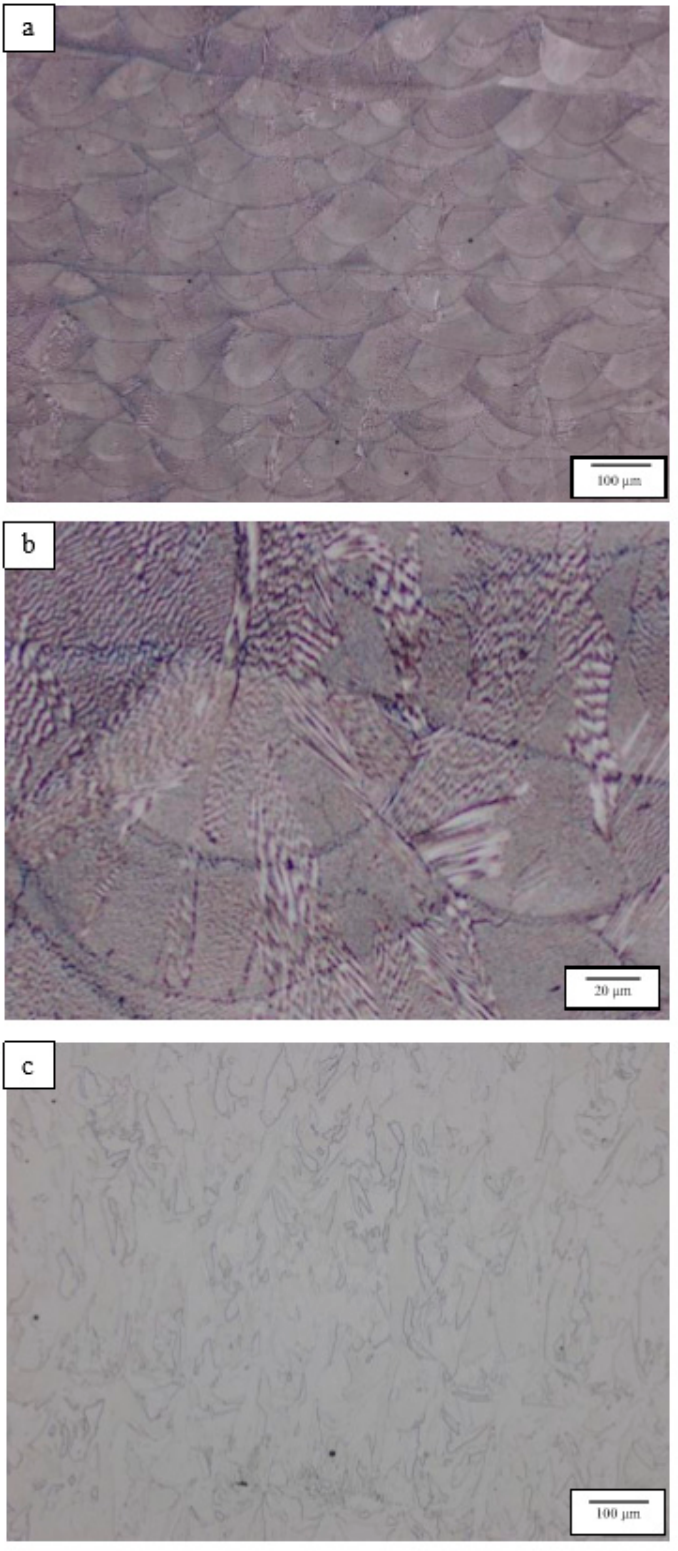
Figure 2. Optical metallography (OM) image of as-built (Variant 1) Inconel 718 alloy component ( a ). ( b ) shows a magnified image of ( a ). ( c ) As-built and stress-relief annealed 718 alloy (Variant 2) (Table 1).